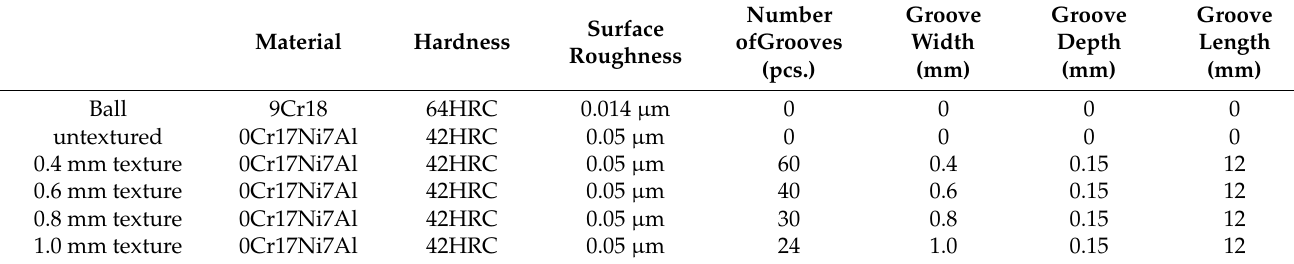
Table 1. Dimensional parameters of the specimens.